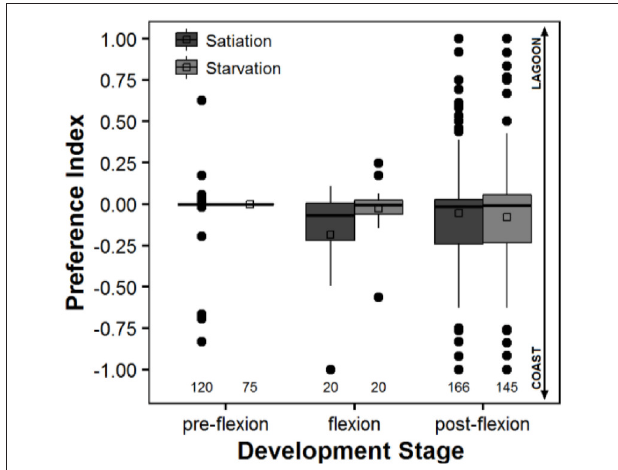
FIGURE 3 | Box-n-whiskers plots representing the Preference Index determined for Sparus aurata larvae under satiation and starvation conditions along their ontogeny. Negative values of this index indicate a preference for coastal water, while positive values indicate a preference for lagoon water. The plot depicts the 1st and 3rd quartiles, median, mean, and outliers, as well as the 5th and 95th percentiles as the minimum and maximum whiskers, respectively. Legend: open squares represent the mean; thick black line represents the median; full black circles represent the outliers; the numbers at the bottom of the graph account for the number of observations made.